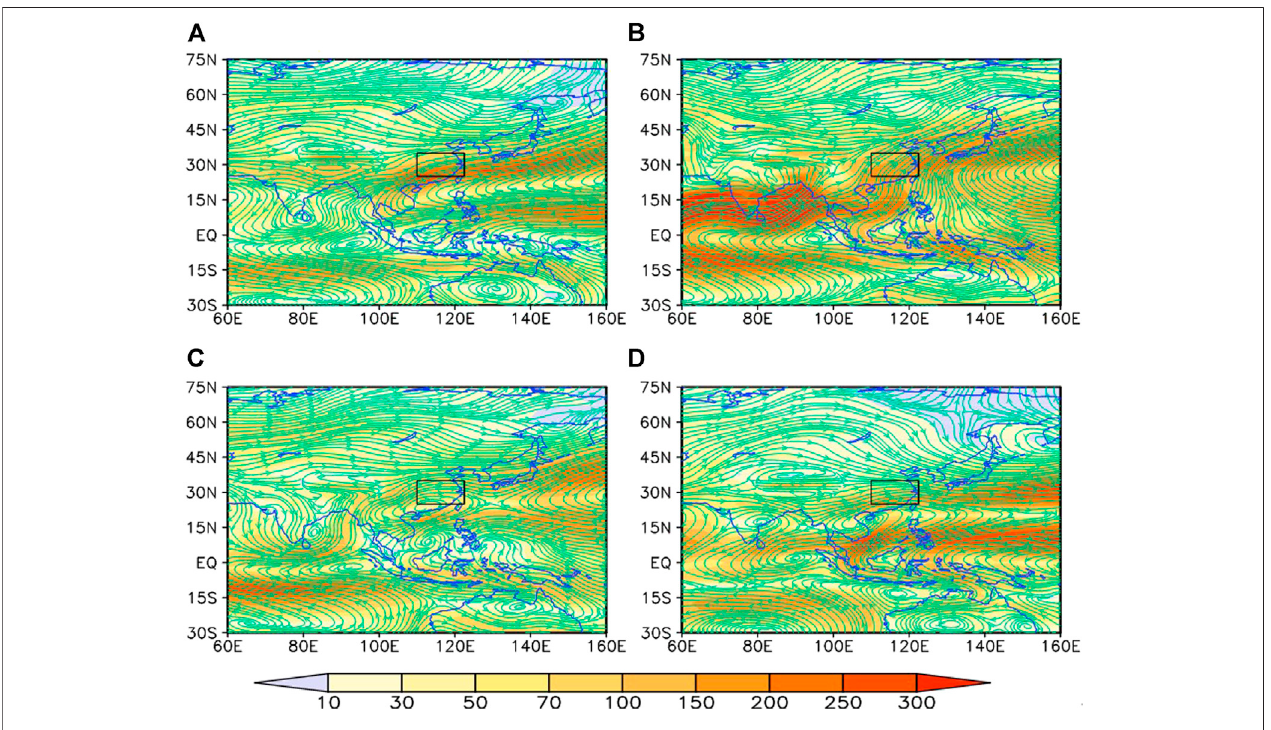
FIGURE 3 | Water vapor fl ux of the whole layer in (A) spring, (B) summer, (C) autumn and (D) winter in the MLRYR (units: kg m − 1 s − 1 ). The vectors represent the direction of the water vapor fl ux in the whole layer and the color shading indicates its speci fi c value. The black rectangular box represents the MLRYR.